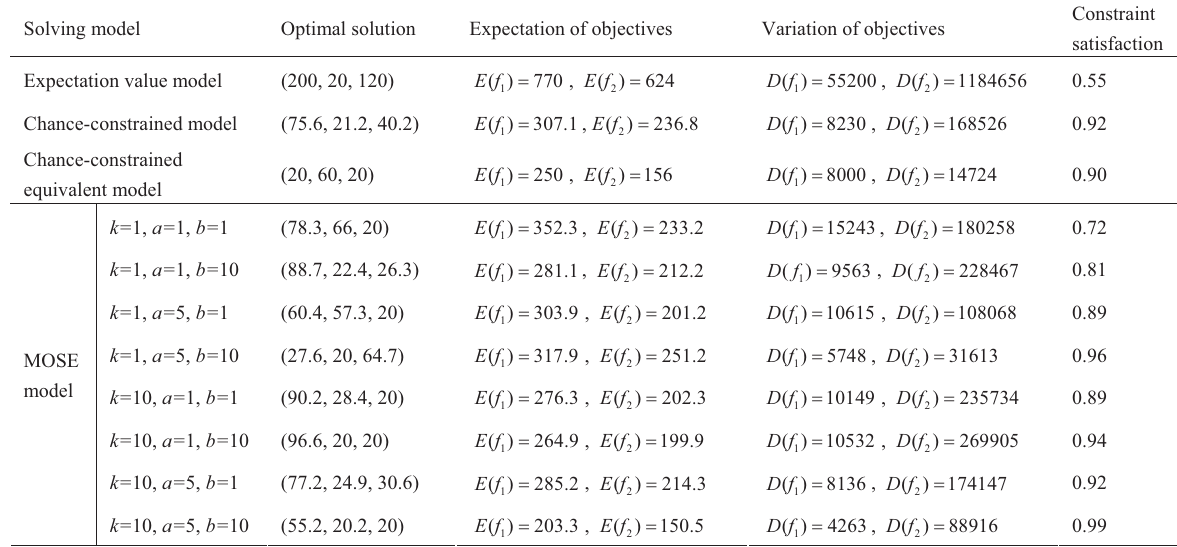
Table 2. The results for every method ( (cid:550)